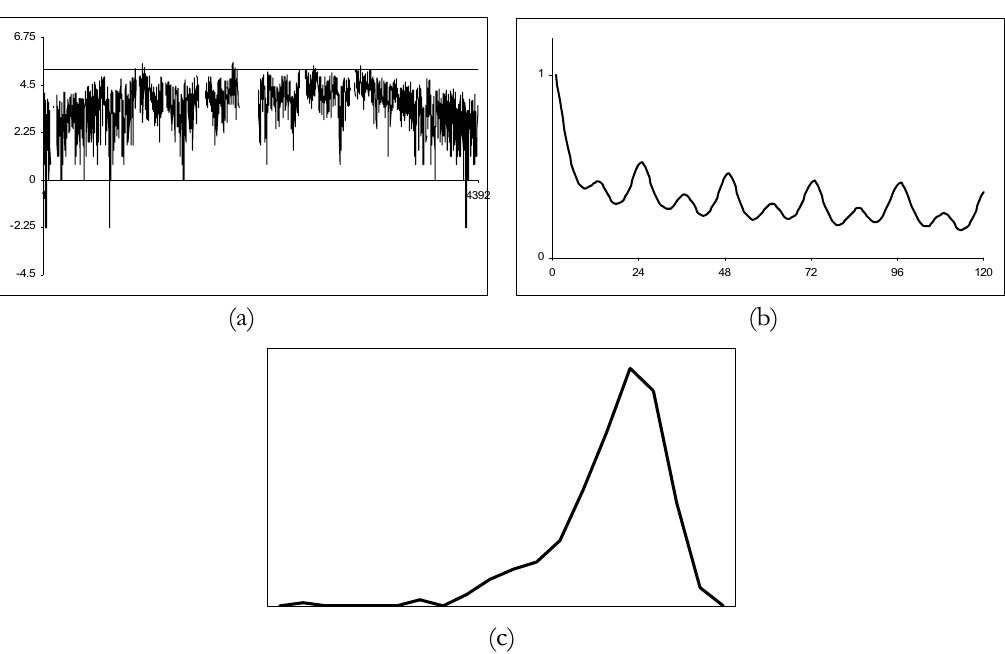
Figure 1 – Series of the O 3 hourly mean log-concentrations with the log of the attention-level (a); the 120 hours correlogram (b) and the continuous approximation of the histogram (c) of the data plot- ted in